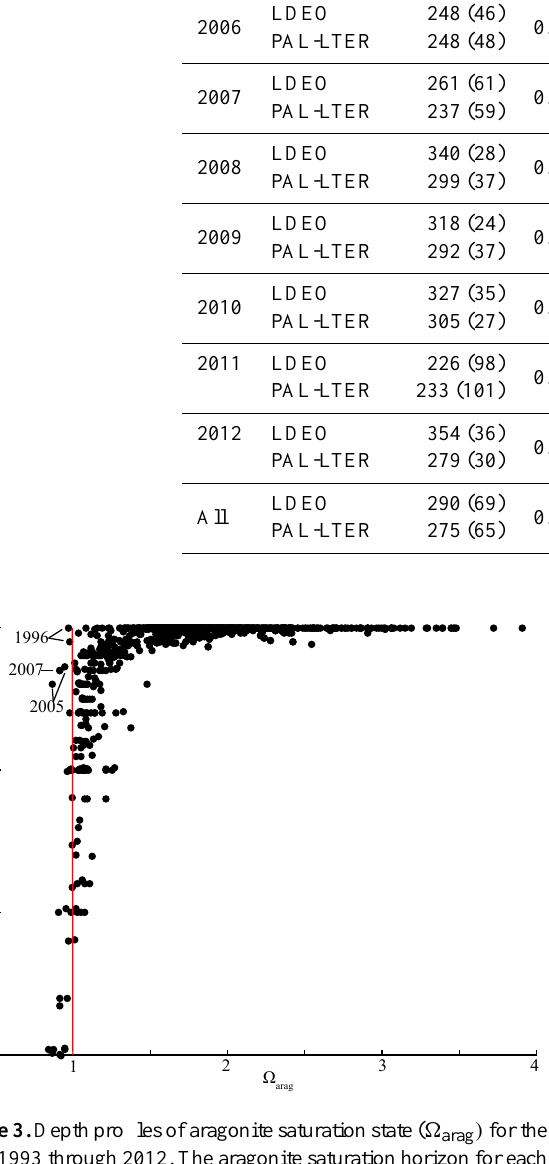
saturation was detected between 100 and 200 m depth in 2005 and 2007 (Fig. 3). At depths > 70 m, which is below the mixed layer depth, (cid:127) arag was < 1.5 in all